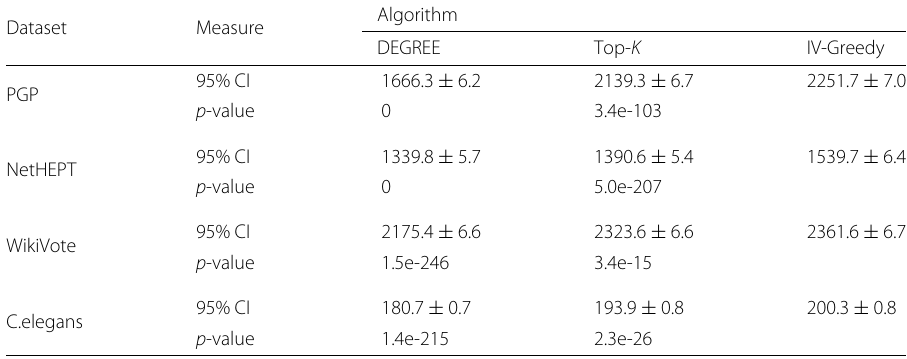
Table 2 Ninety-five percent confidence intervals and p -values for the expected influence spread of the four network datasets based on 1000 runs of MC simulation for each dataset